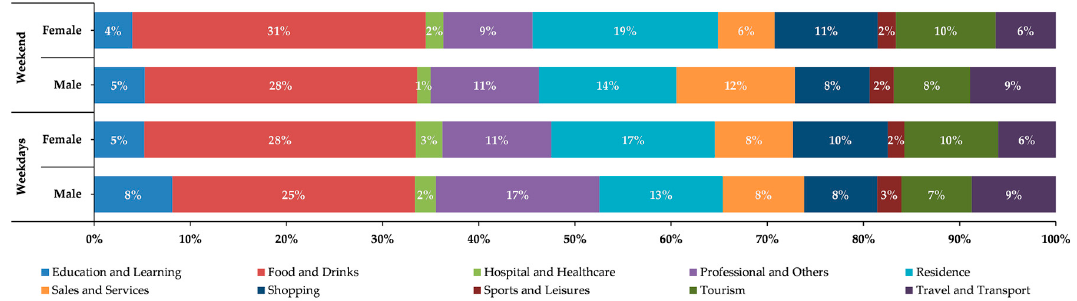
Figure 4. Check-in distribution of activities in Shanghai.